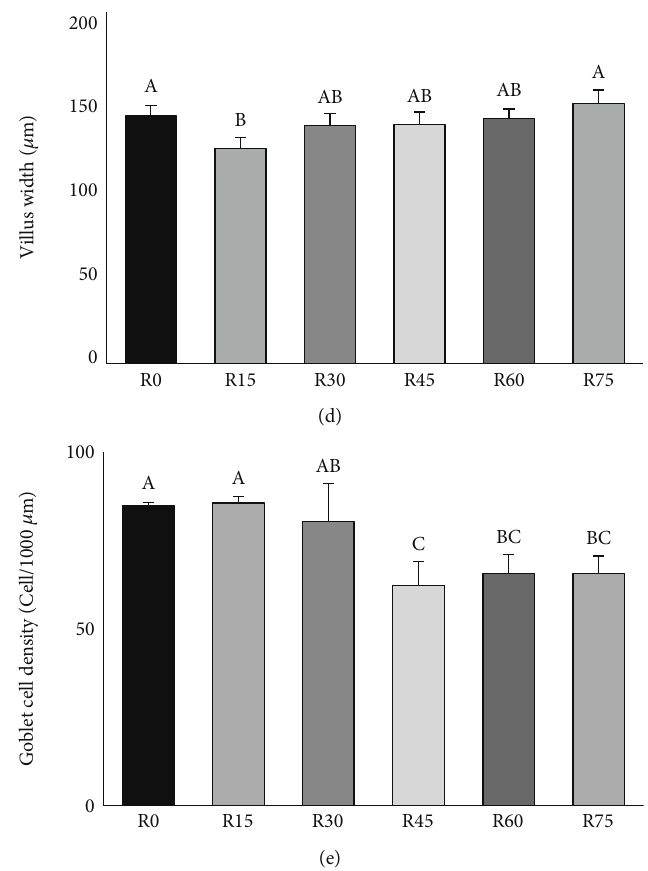
Figure 2: Intestinal diameter (a), muscular thickness (b), villus length (c), villus width (d), and goblet cell density (e) of midgut in Japanese eel fed with di ff erent replacement levels of defatted black soldier fl y larvae meal (DBSFLM). Data are presented as mean ± standard deviation ( n = 15 ). Di ff erent superscript letters indicate statistically di ff erent values ( P < 0 : 05